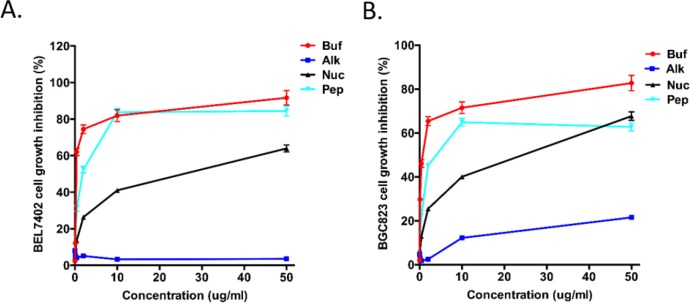
Evaluation of antitumor effects of different Cinobufacin components.Growth inhibition effects of different concentrations of bufadienolides (Buf), alkaloids (Alk), nucleosides (Nuc), and peptides (Pep) extracted from Cinobufacin on BEL-7402 (A) and BGC-823 cells (B). Cells was monitored for 48hrs after adding different Cinobufacin extracts.